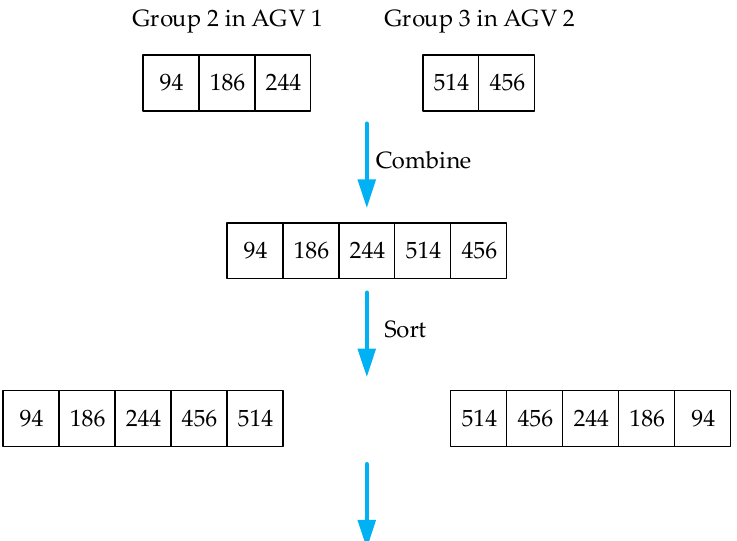
Two sequences are placed in the original position of group 3 in AGV 2 as two candidate solutions. Figure 8. An example in a relocation operator when group 2 in AGV 1 (not be split) is relocated into group 3 in AGV 2.